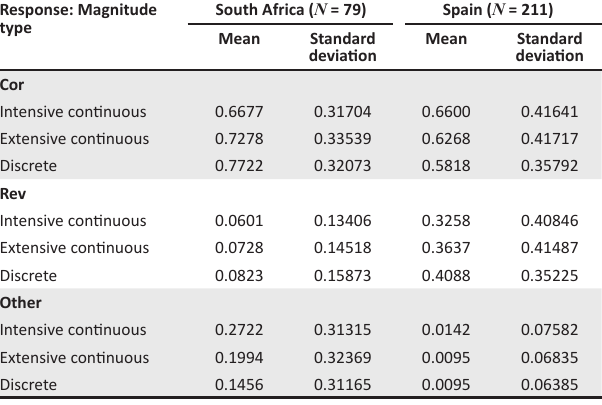
TABLE 3: Descriptive statistics by country and magnitude type. Response: Magnitude